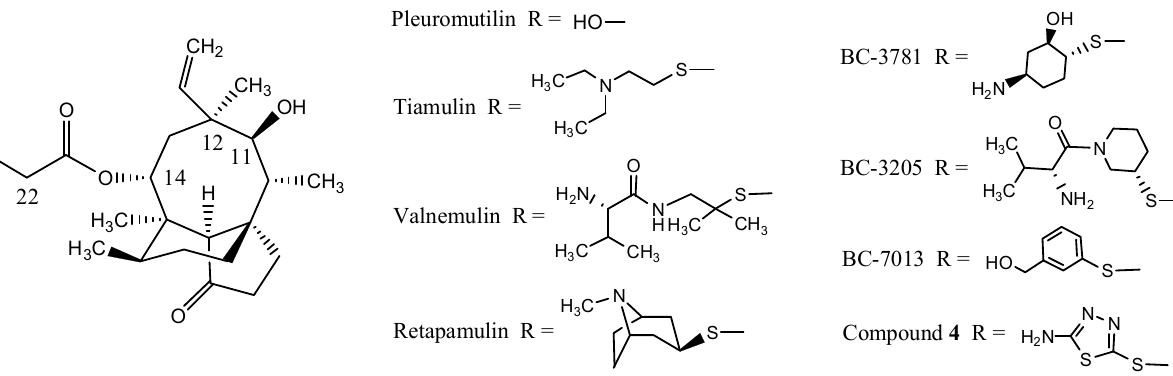
Figure 1. Structural formulas of pleuromutilin, tiamulin, valnemulin, retapamulin, BC-3781, BC-3205 and